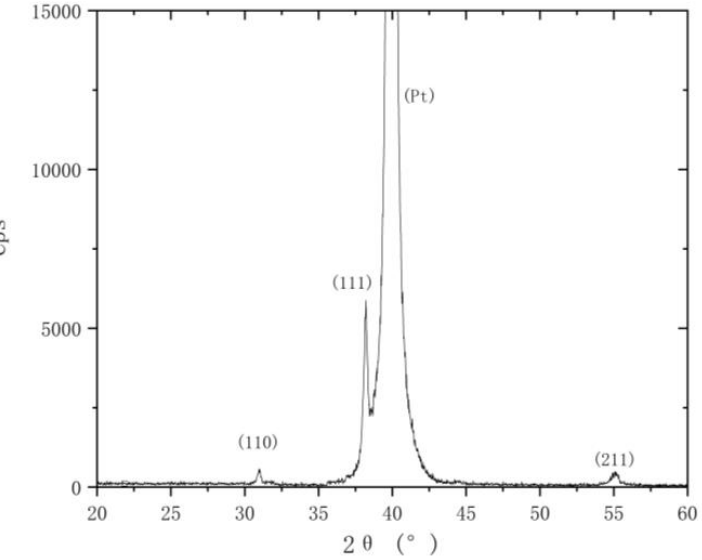
Figure 10. X-ray diffraction (XRD) of the PZT film. The crystal orientations of the PZT film along the (110), (111) and (211) directions have diffraction intensity, while there is almost no diffraction intensity at other diffraction angles; the PZT film has the highest diffraction intensity along the (111) direction.